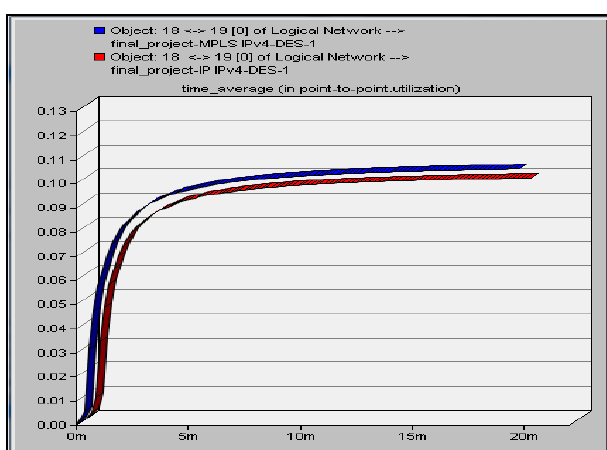
Figure22 Link Utilization Comparison of IPv4,IPv4 over MPLS and IPv4 over MPLS-TE along 18 to 19 Link